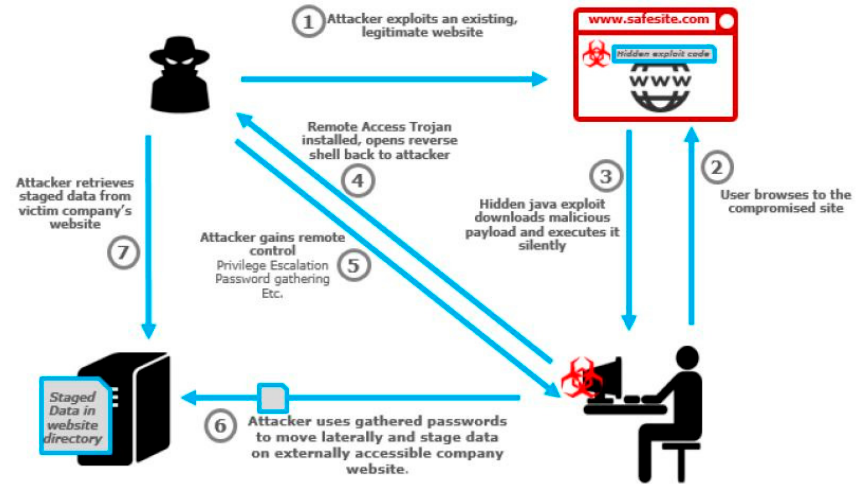
Figure 9. Typical sequence of events in a drive-by-download attack [43].